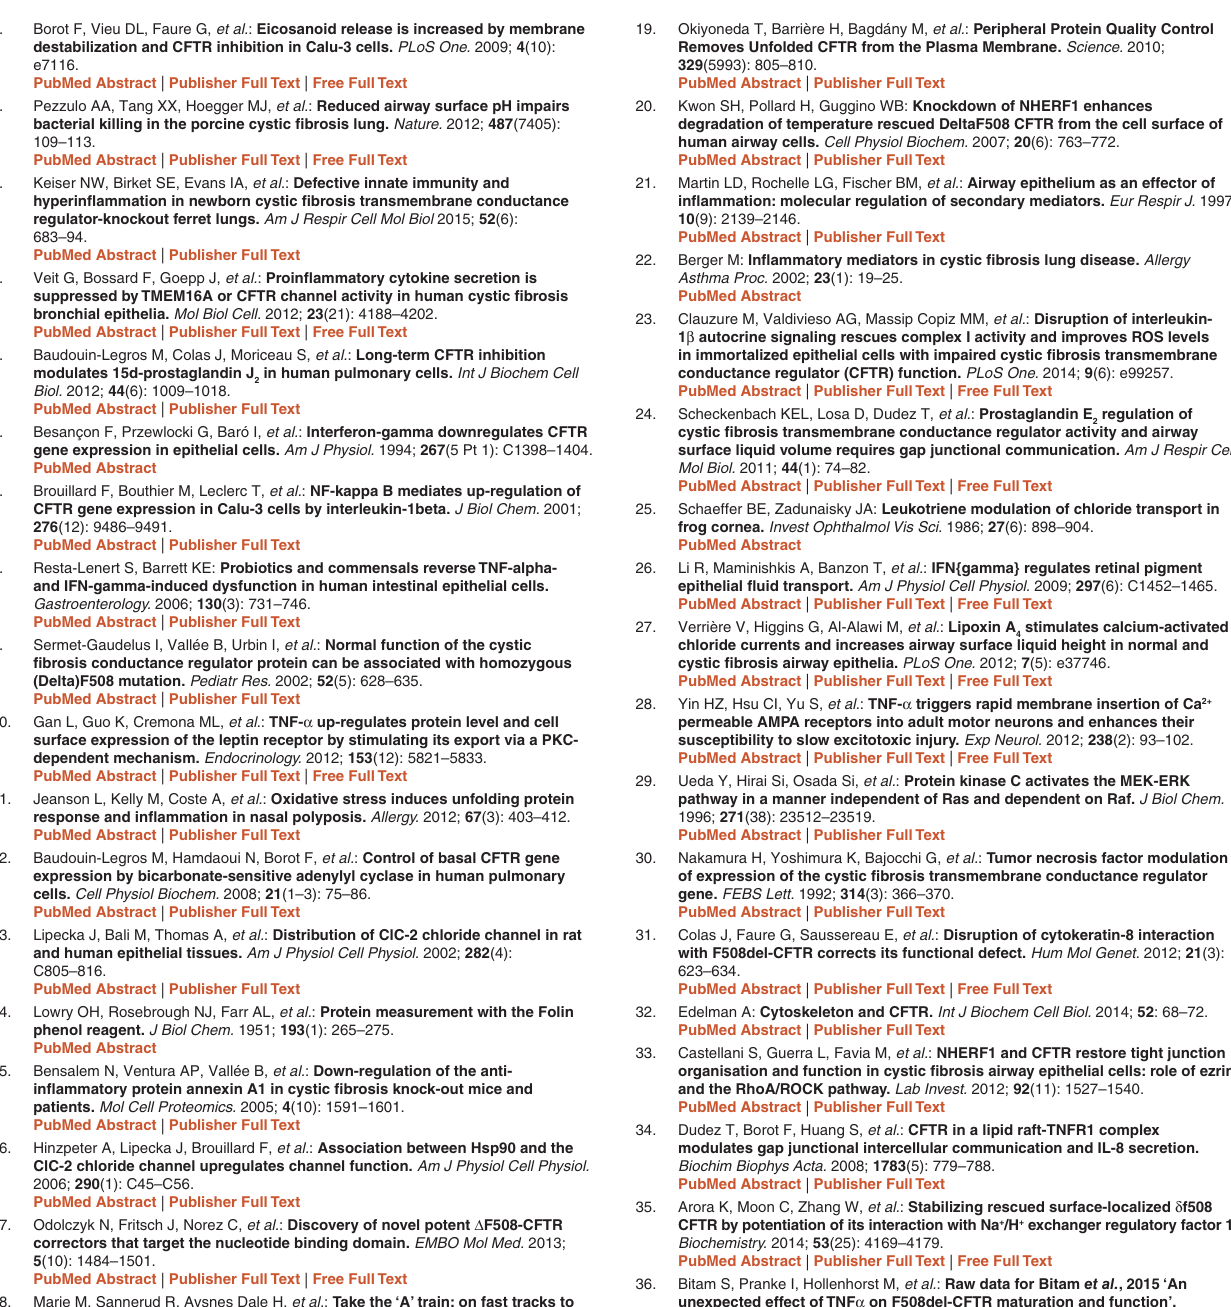
Figshare. 2015. Data